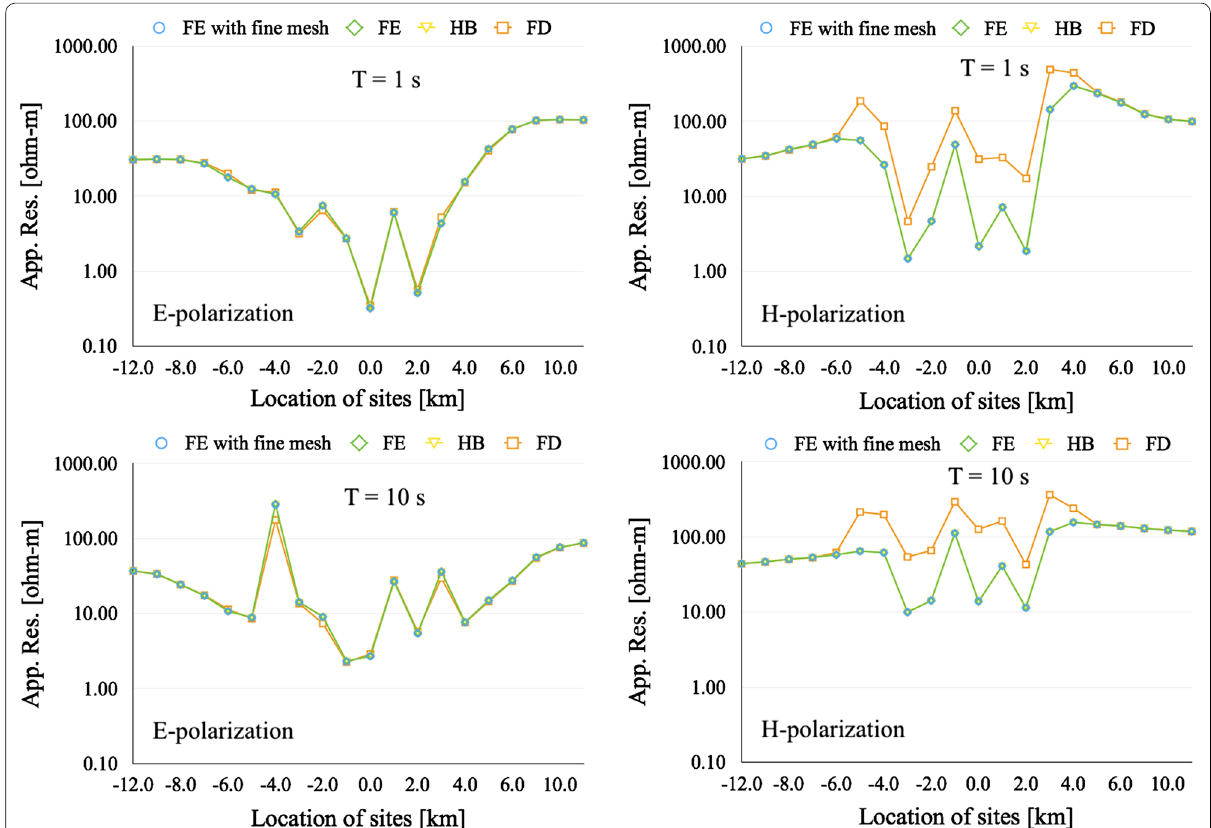
Fig. 12 The apparent resistivities computed at T = 1s of the bathymetric model for the E - and H - polarizations are shown at the left and right top, respectively, whereas those computed at T = 10s are shown at the left and right bottom, respectively